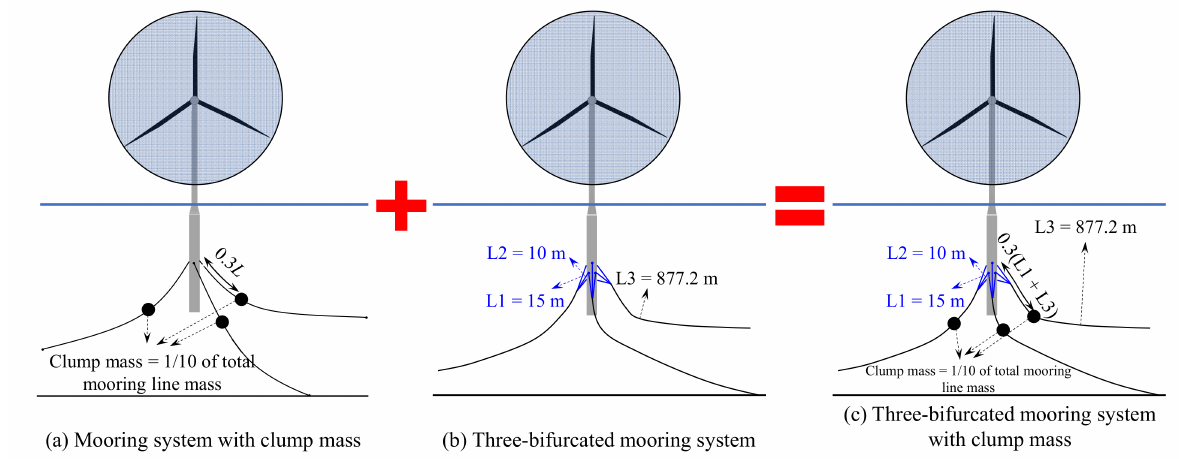
Figure 15. Schematics of the ( a ) mooring system with clump mass, ( b ) three-bifurcated mooring system, and ( c ) three- bifurcated mooring system with clump